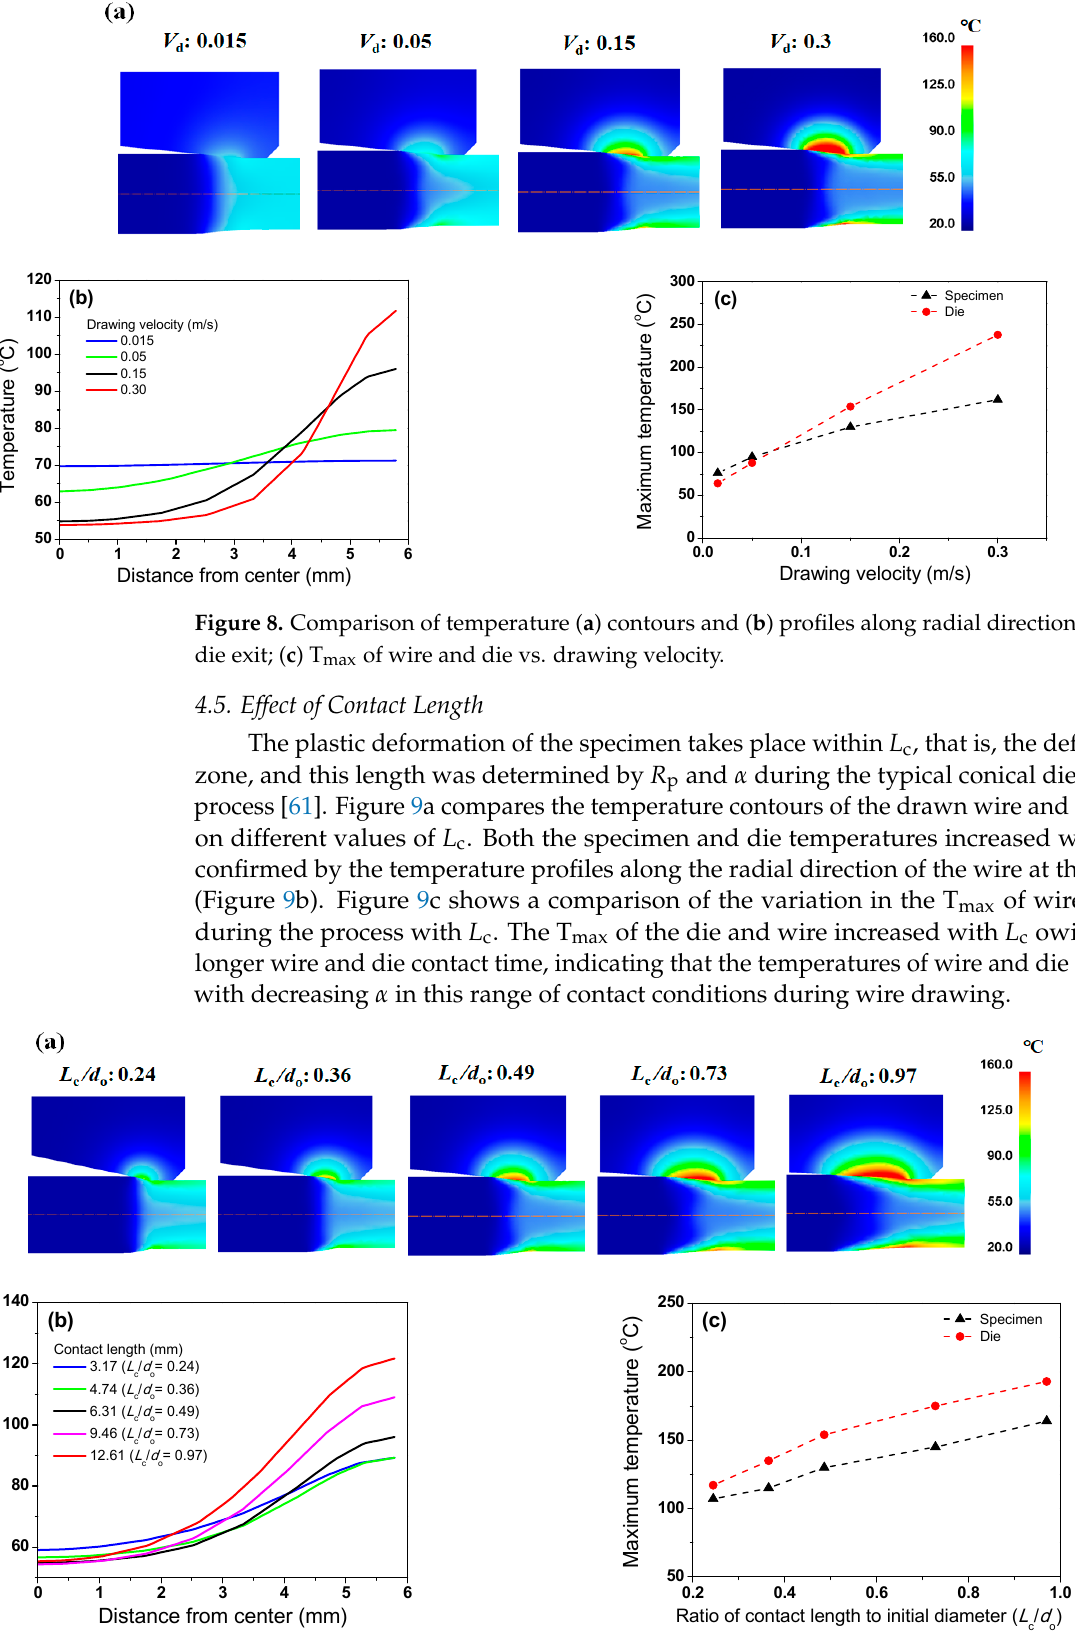
9 of 15 Figure 7. Comparison of temperature ( a ) contours and ( b ) profiles along radial direction of wire at die exit; ( c ) T max of wire and die vs. shear fraction factor. Meanwhile, it should be noted that the friction coefficient at the wire–die interface and wear of wire typically increased with increasing wire temperature during wire drawing because high temperature softened wire materials and sometimes promoted the oxidation of the metal. The softened materials can be easily sheared and removed under frictional stress, resulting in high wear depth [48]. Therefore, to overcome this drawback, the research on the streamlined die [49,50], hydrodynamic lubrication [51,52], die coating [53], and ultrasonically oscillating dies [54–56] have been conducted in the wire drawing research fields. In addition, the frictional stress at the wire–die interface affected the material properties at the surface of the wire during wire drawing [57]. 4.4. Effect of Drawing Velocity During wire drawing, the wire temperature as well as material properties are sig- nificantly affected by V d [16,18,21,31,58,59]. Figure 8a shows the temperature contours of the specimen and die for the different values of V d , and Figure 8b shows a comparison of the temperature profiles along the radial direction of the wire at the die exit. As ex- pected, the temperatures of both the wire and die increased with V d , which is consistent with the previous results [59]. The temperature gradient along the radial direction of the specimen increased with V d due to the effect of frictional heating. As V d increased, the temperature gradient inside the wire became stronger because the heat generated by